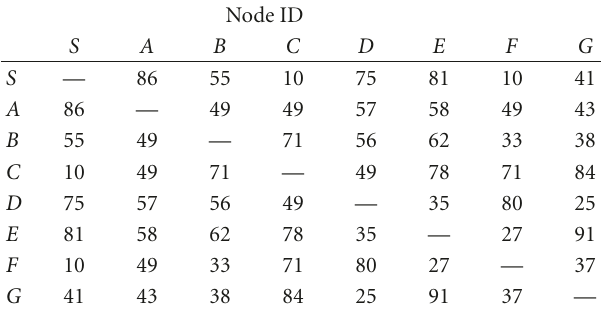
Algorithm 3: Calculating the dominating set (DS) based on constraints relaxation. Table 1: Probability of contacts based on previous contact duration (percentage).